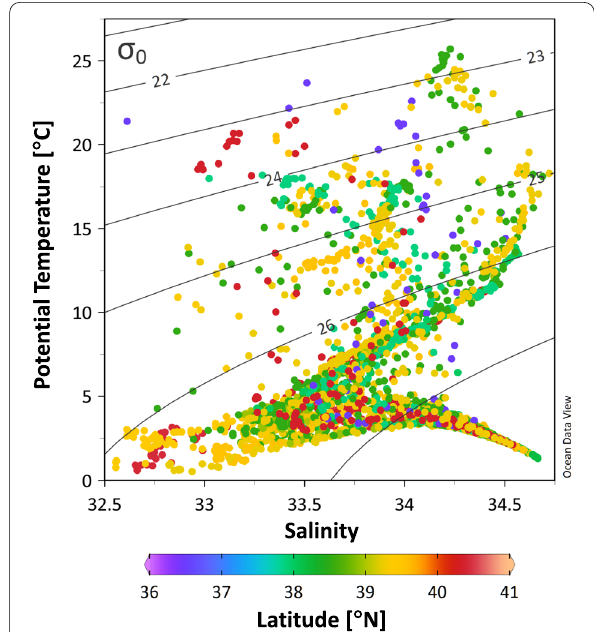
Fig. 3 Potential temperature–salinity diagram for our ship-based hydrographic observations. Contours show isopycnal surfaces. Colored circles denote the latitude of sampling